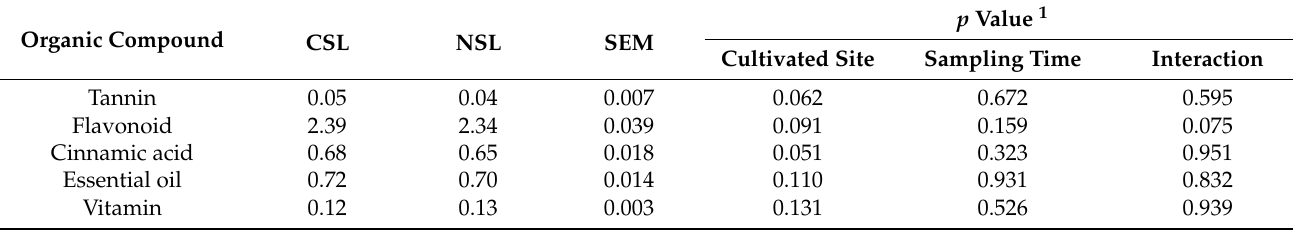
Table 4. Total contents of tannin, flavonoids, cinnamic acid, essential oil, and vitamins in commercial P. sarmentosum leaves (CSL) and non-commercial P. sarmentosum leaves (NSL). Organic